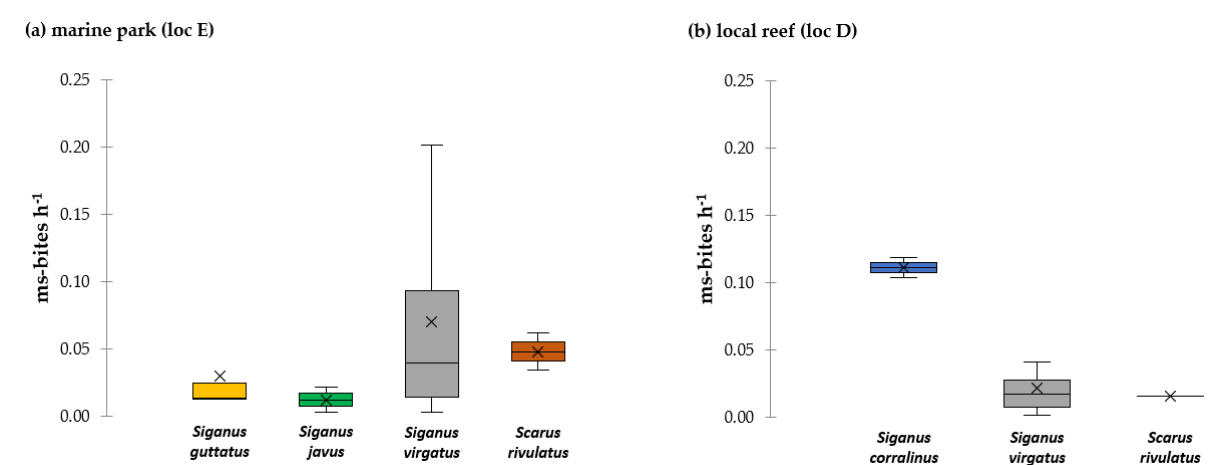
Figure 2. Herbivore biomass surveyed on the reef crest in the marine park (loc E) ( a ) and in a local reef (loc D) ( b ) in 2015. Values are given in mean g mˉ 2 . The boxplot shows the median and 25% quantile, the black cross indicates the mean. In the 2015 single-choice experiments on the reef crest, a total of 438.74 ms-bites dur- ing 124 h of recording (3.54 ± 0.68 ms-bites h − 1 ) were observed (Figure 3). S. virgatus took by far most bites from deployed Turbinaria assays, accounting for 93% of all ms-bites (3.29 ± 0.37 ms-bites h − 1 ), followed by S. corallinus (5% of all ms-bites, 0.16 ± 0.09 ms-bites h − 1 )